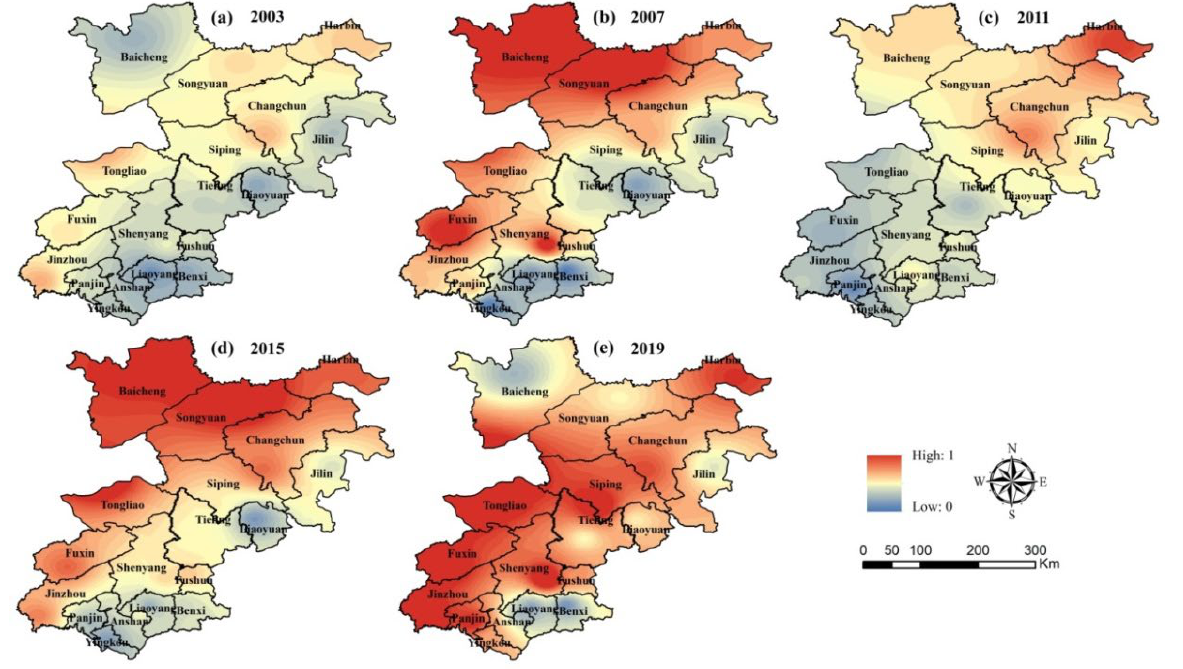
Figure 7. Spatial distributions of drought vulnerability of maize.